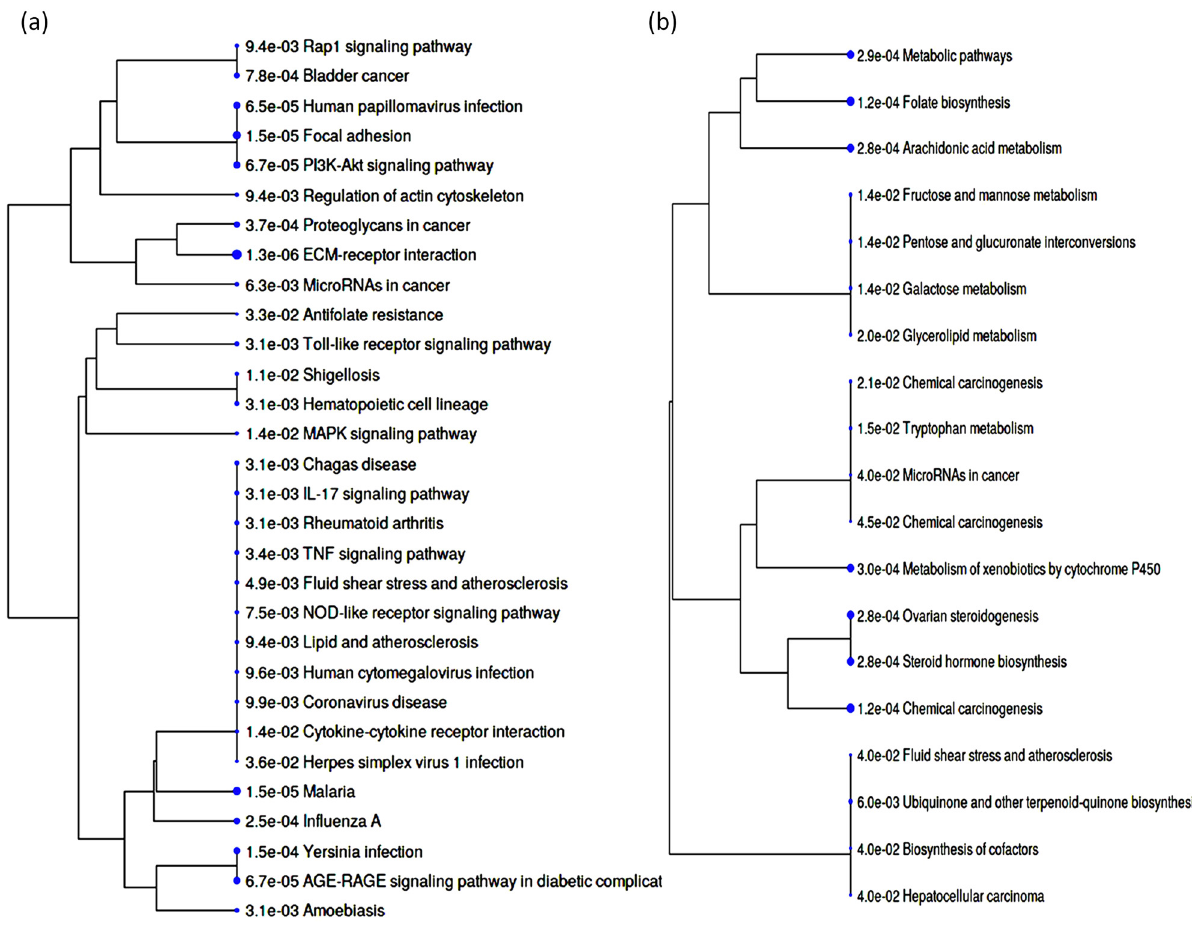
Figure 8: GO enrichment analysis. A hierarchical clustering tree summarizing the correlation among signi fi cant biological processes for DEGs from two clusters ( a ) cluster 1; ( b ) cluster 2 of data sets GSE5058, GSE11784, and GSE11906. Biological processes with many shared genes in common are grouped. Bigger dots indicate larger values of statistical di ff erences ( p )